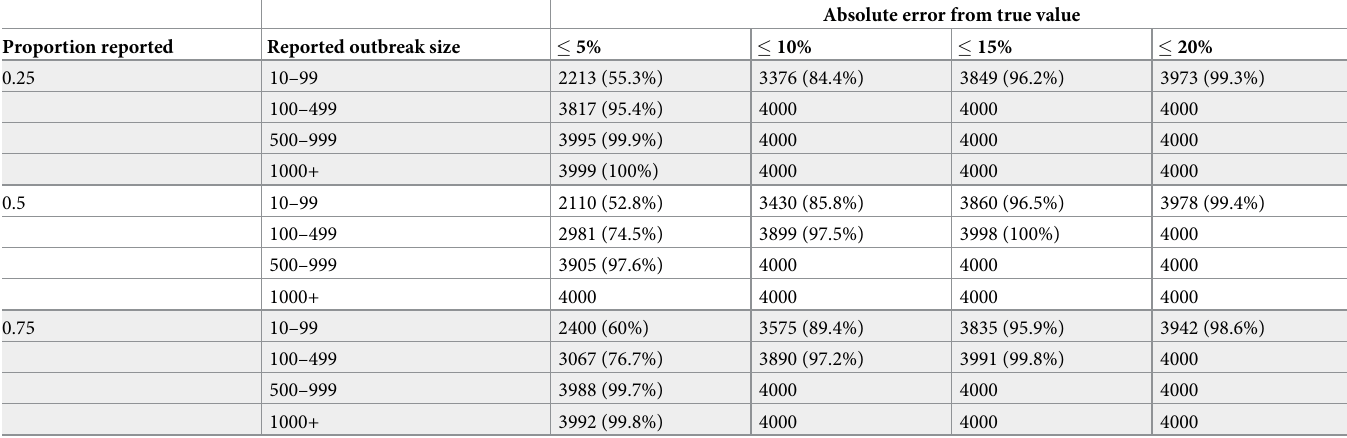
Table 4. Comparison of absolute error from 4000 simulations between true reporting levels and estimate of reporting by reported outbreak size and true reporting level. Proportion